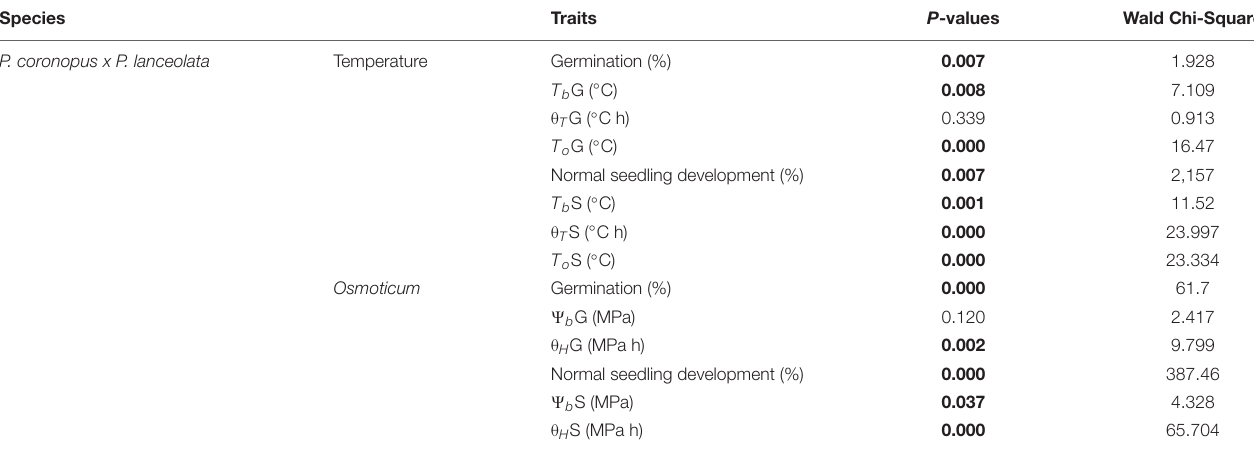
TABLE 1 | Statistical results for the generalized linear model (GLM) tests of the maximum germination (G) and development to the seedling (cotyledon-open) (S) stage performed with the binomial distribution and logit link function with species as a predictor factor using the maximum likelihood estimation method, Wald Chi-Square statistics, and contrast pairwise